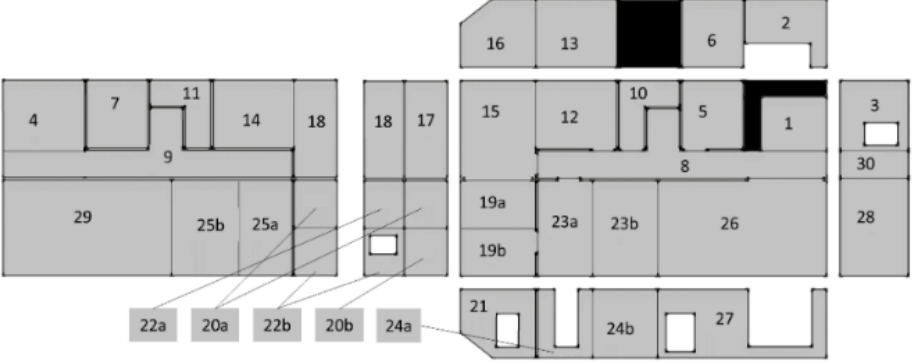
Figure 6. Thermal active panels cutting.